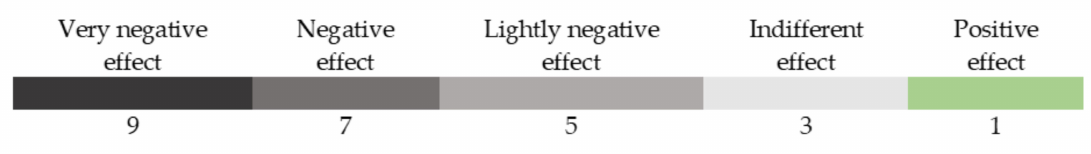
Figure 2. Scoring scheme for social inventory